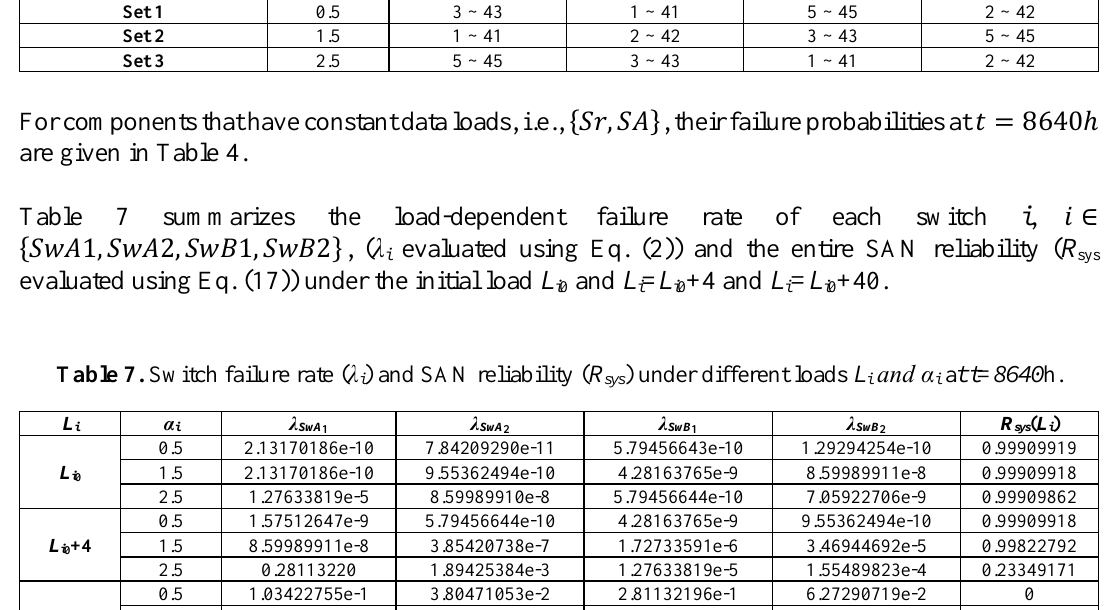
Table 6. L i and α i , 𝑖 ∈ {𝑆𝑤𝐴1, 𝑆𝑤𝐴2, 𝑆𝑤𝐵1, 𝑆𝑤𝐵2} . Parameter